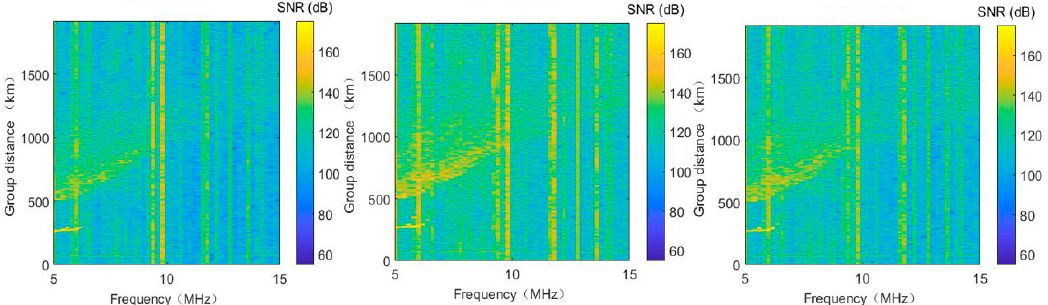
Figure 9. Oblique backscatter ionograms of six channels.